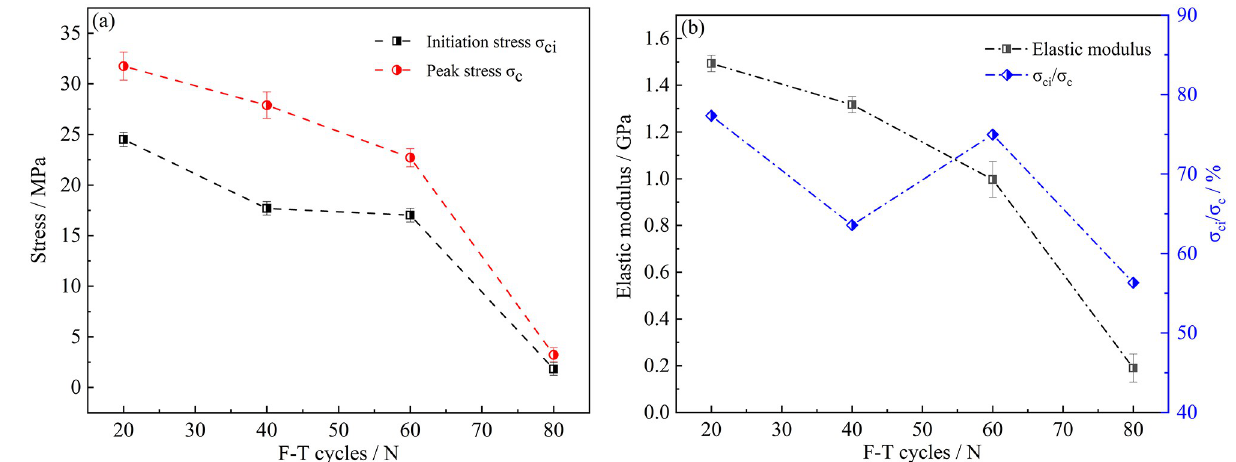
Fig 3. The stress threshold of sandstone specimens under different